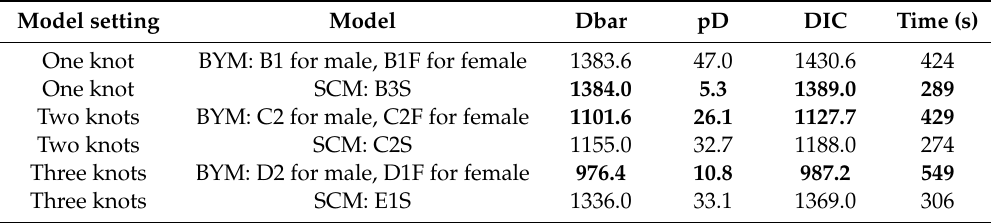
Table A3. Comparison of spatio-temporal BYM and SCM